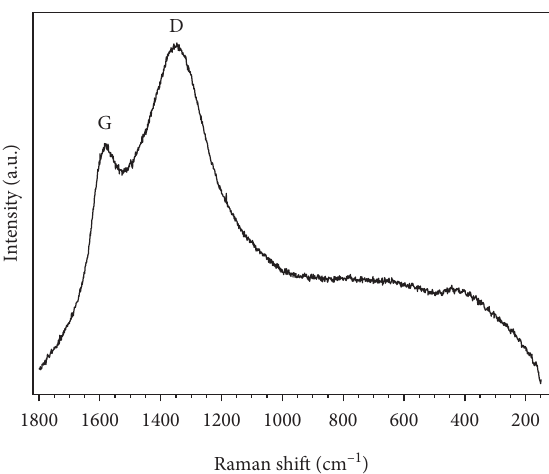
Figure 5: Typical Raman spectra of the soot deposits obtained in the IRMPD process of